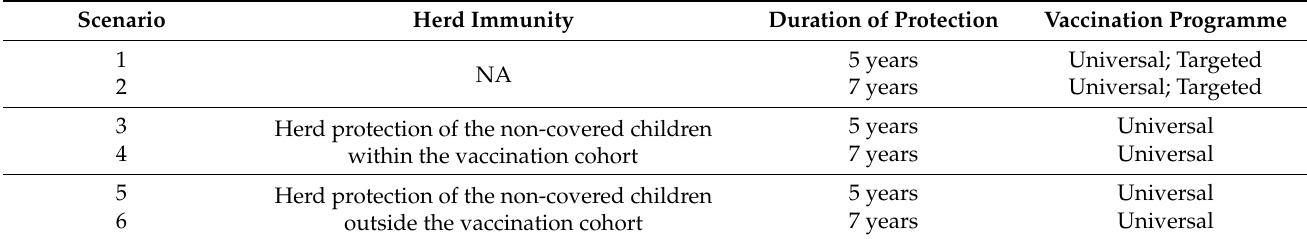
Table 4. Scenarios 1 to 6.